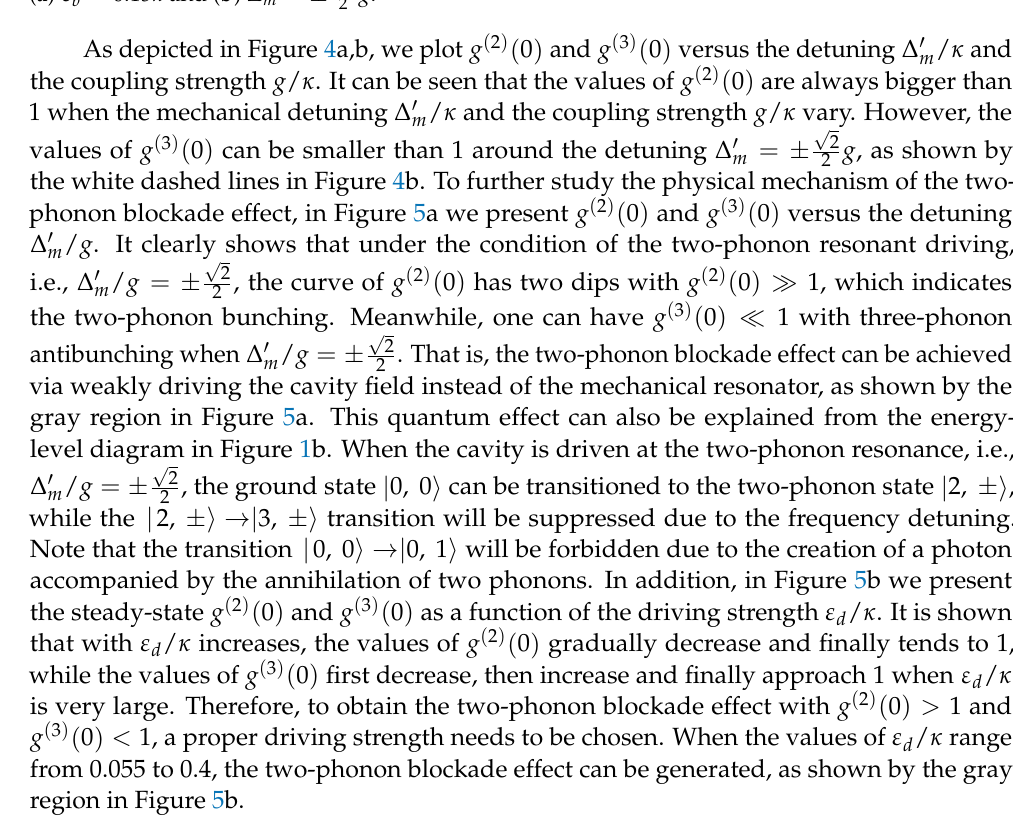
Figure 3. Steady-state equal-time second-order correlation function g ( 2 ) ( 0 ) and third-order corre- lation function g ( 3 ) ( 0 ) versus ( a ) the detuning ∆ m / g and ( b ) the driving strength ε b / κ when the mechanical resonator is weakly driven. The system parameters are γ = 0.01 κ , n th = 0, g = 2 κ , √ 2 g ( a ) ε b = 0.15 κ and ( b ) ∆ m = ± 2